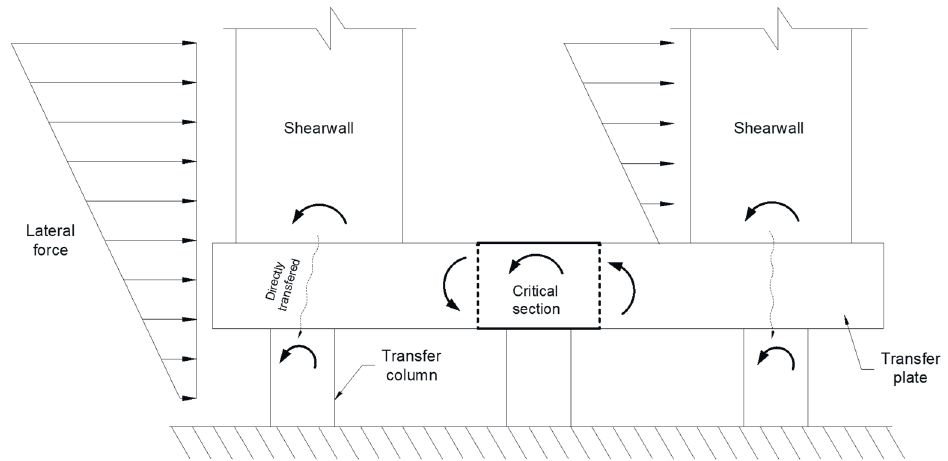
Figure 14. Moment transfer under later load.